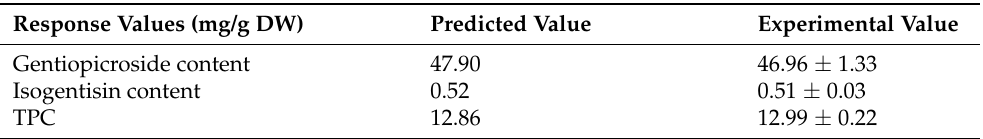
Table 3. Comparison between predicted and experimentally obtained values for investigated re- sponses under calculated optimal